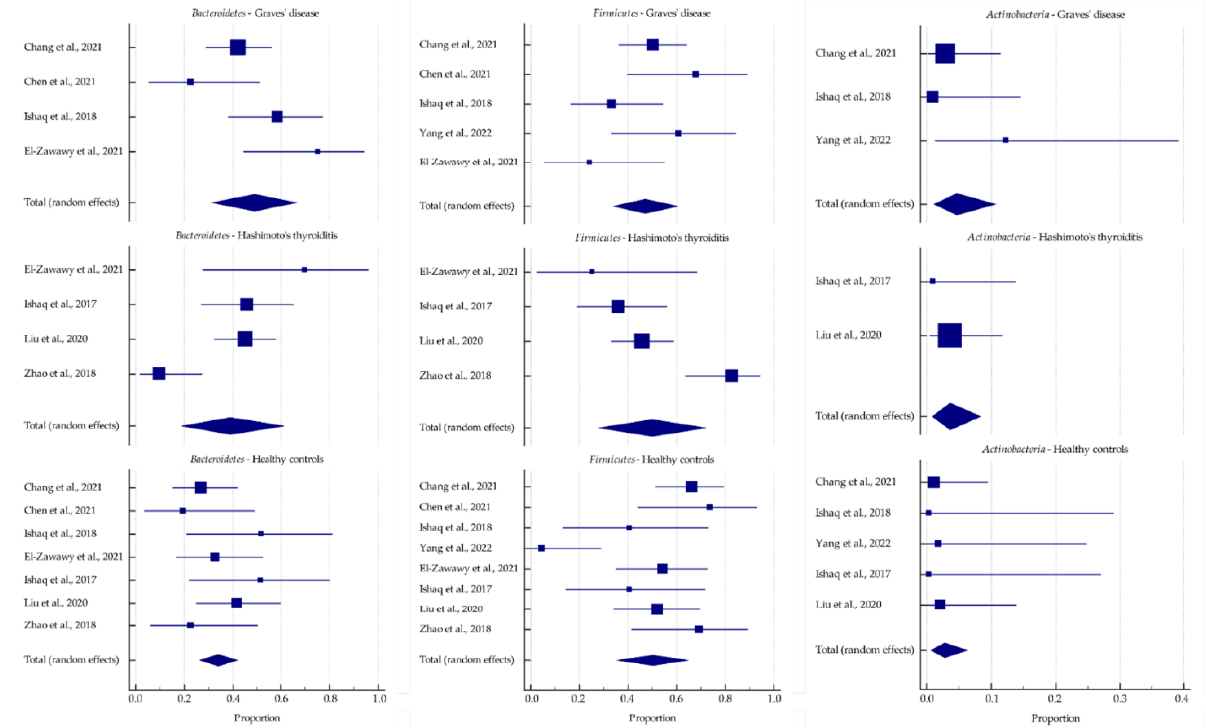
Figure 5. Forest plots representing the pooled relative abundance for the most common phyla in the included studies [30–32,38,41,43–45].